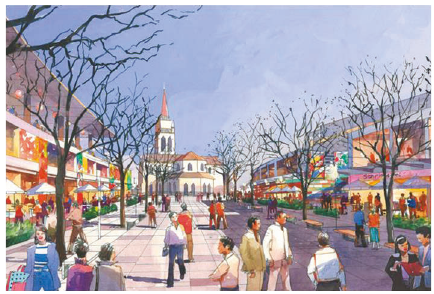
Figure 1: Schematic diagram of green